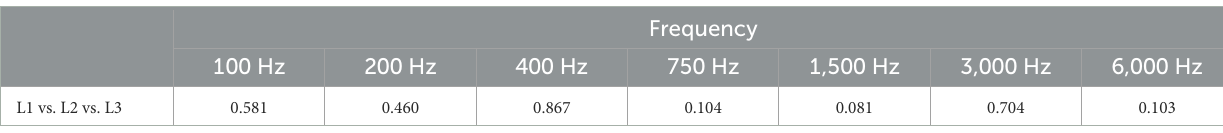
TABLE 5 The p -values of the Friedman for SPLIR comparing the three different physiological sites L1, L2, and L3 at all frequencies and amplitudes is